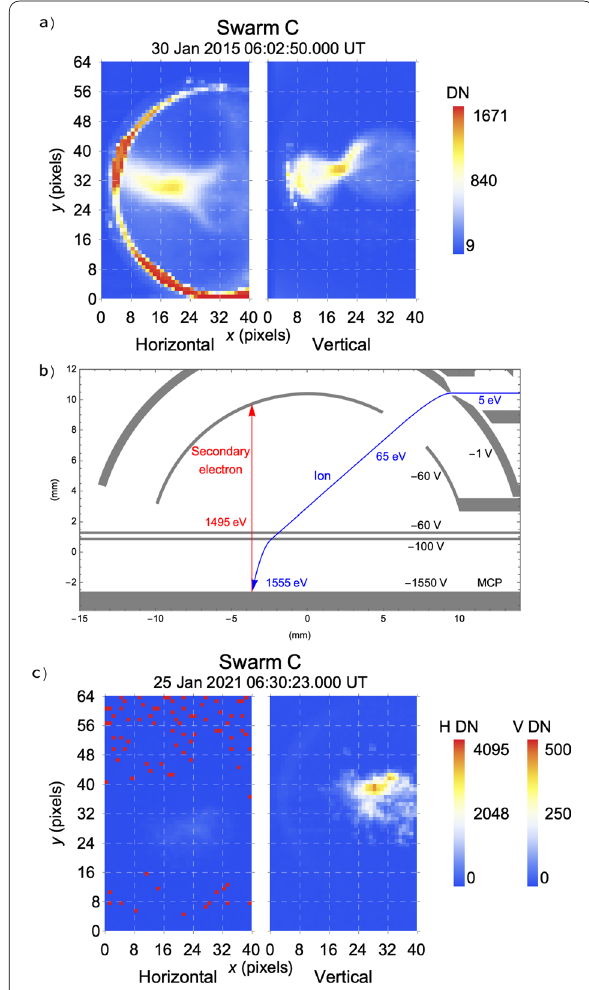
Fig. 10 ( a ) Swarm C TII example of the ring anomaly, appearing as a bright arc and defocusing of the rammed ion spot, particularly evident in the left-hand panel. ( b ) Illustration of secondary electron feedback from the input surface of the MCP. Electrode voltages are labeled in black, ion kinetic energy in blue, and electron kinetic energy in red. ( c ) The “measles” anomaly consisting of quasi-randomly distributed pixel count rates of 4095 DN